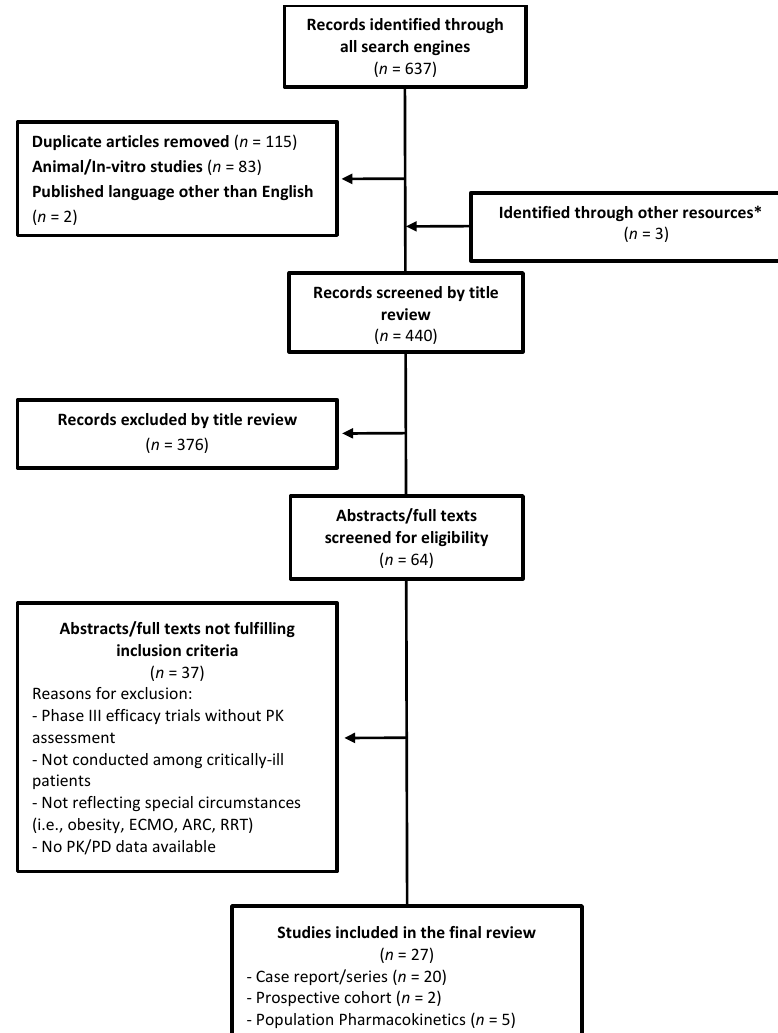
Figure 1. Flow diagram of the study selection. * Three abstracts/posters were indentified through searching and were included in the review since pertinent data regarding PK/PD and target attainments in critically ‐ ill patients were available.